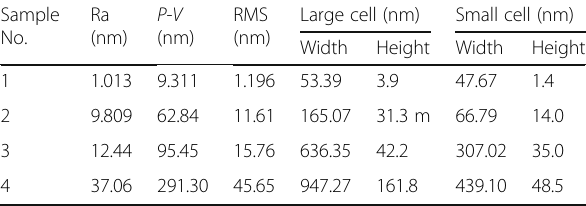
Table 2 AFM test results of GeBi films with different Bi contents Sample No.